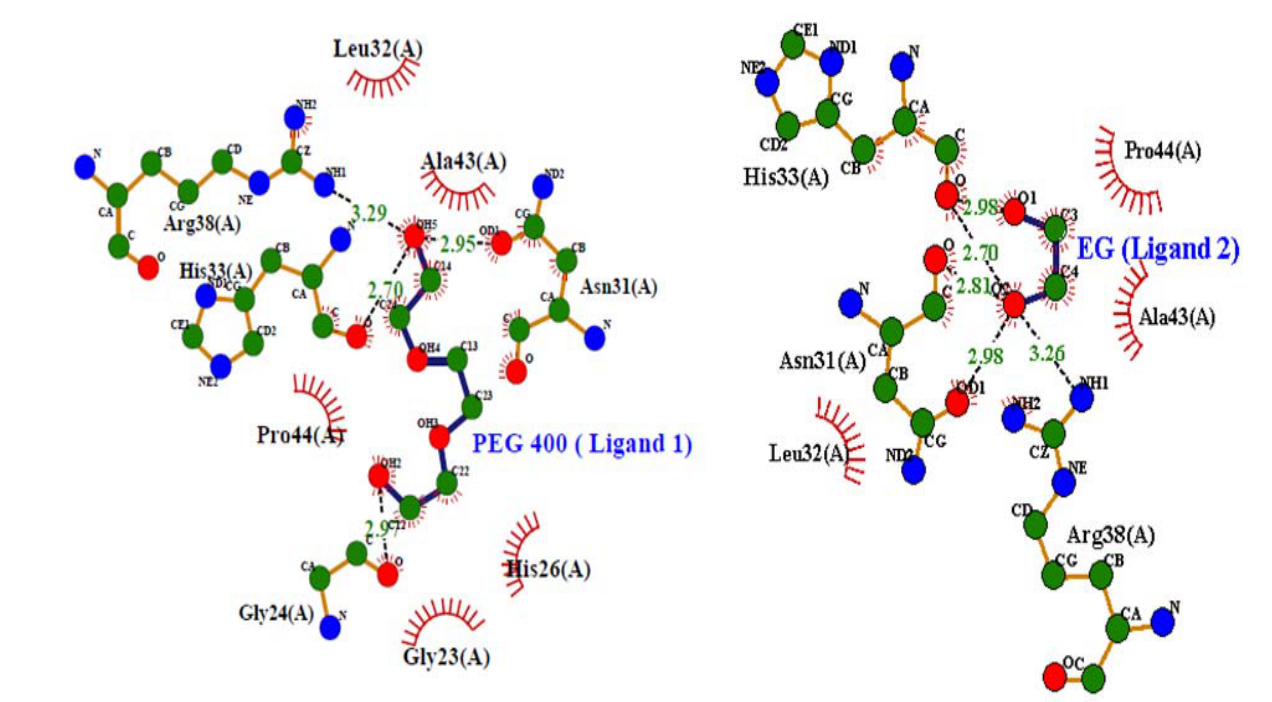
Figure 6. LigPlots showing the various types of interactions of PEG 400 and EG with residues of cyt c .